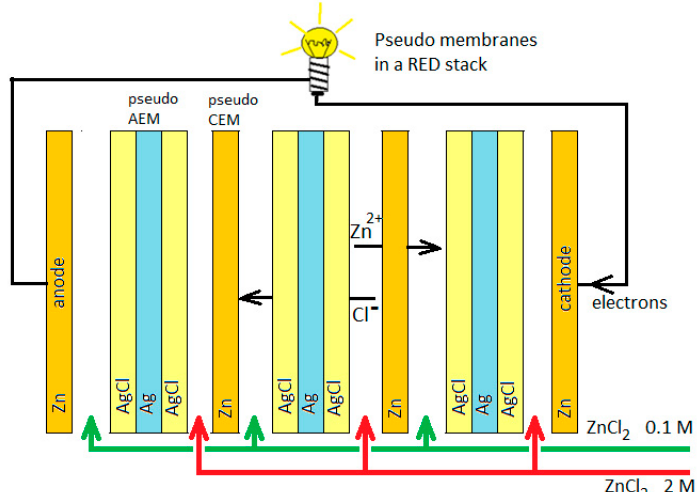
Figure 1. Concept of a reverse electrodialysis (RED) stack equipped with inorganic pseudo-membranes. AEM, anion exchange membrane; CEM, cation exchange membrane.